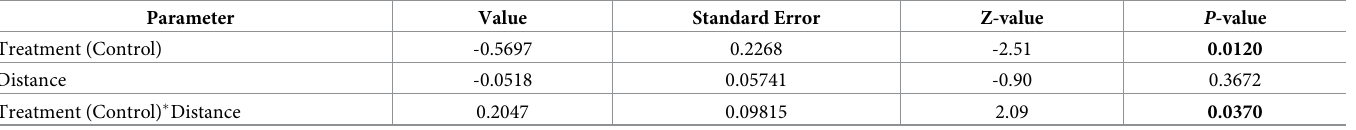
Table 5. Estimates from a CPHM of parameters affecting mosquito mortality upon exposure to emanators indoors.